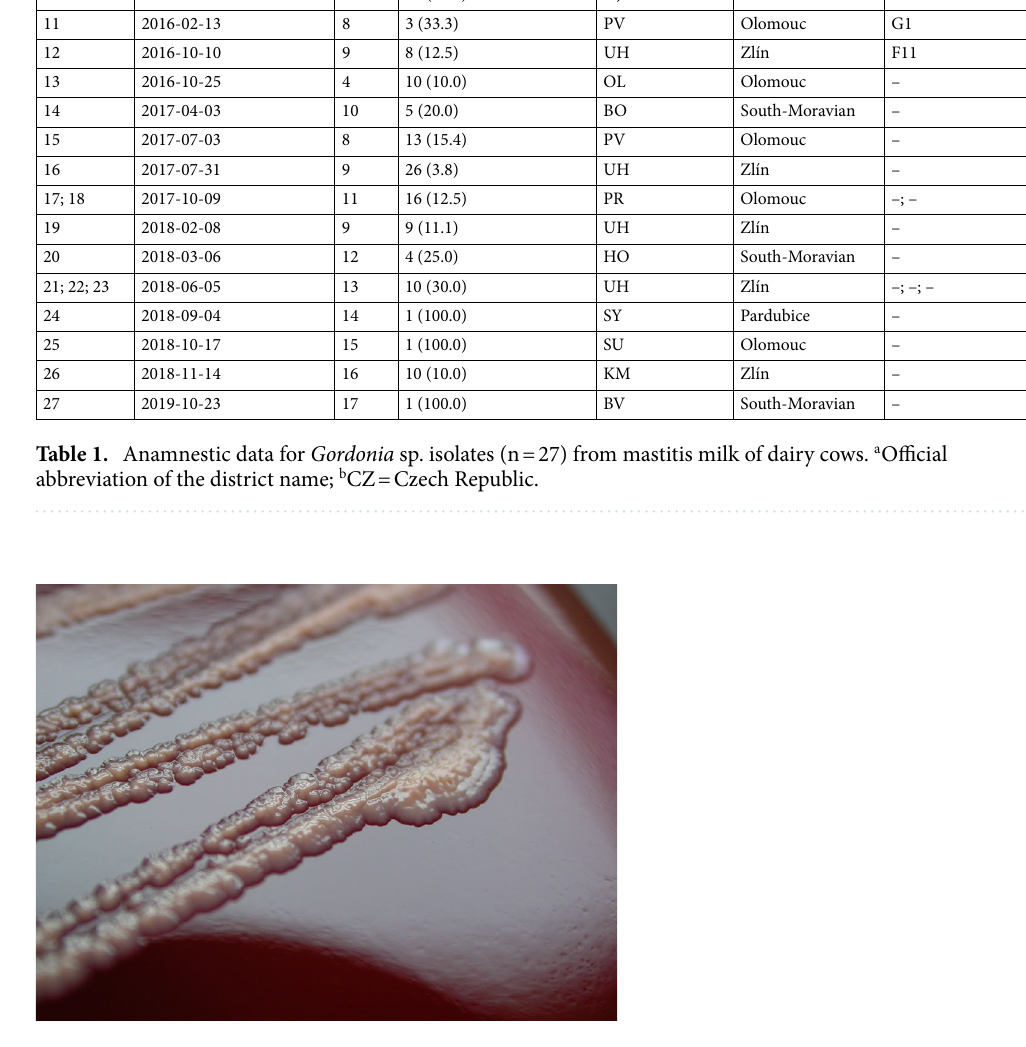
Figure 2. Gordonia paraffinivorans growth on a Meat Peptone Blood Agar plate after 72 h of incubation of pure culture isolated from primary culture of a milk